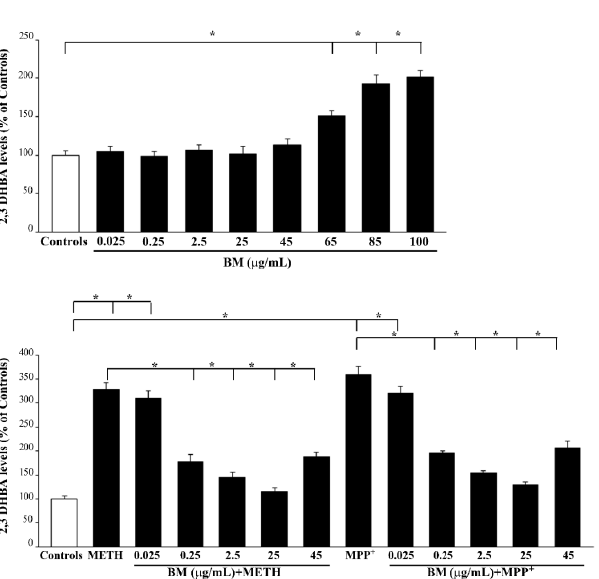
Figure 7. Low doses of BM decrease METH- and MPP + -induced ROS formation The graphs report the levels of 2,3 DHBA produced by increasing doses of BM alone ( A ) and combined treatment of BM and METH or MPP + ( B ). Values are given as the mean percentage ± S.E.M. of controls (assuming controls as 100% density). Data are obtained from three independent experiments. * p < 0.05 com- pared with